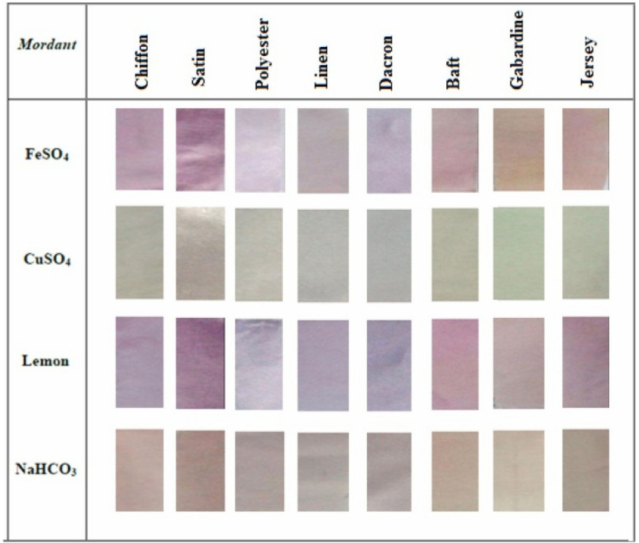
Figure 6. Different color hues obtained after applying different mordants (Reprinted with permission from reference [24]. Copyright 2021